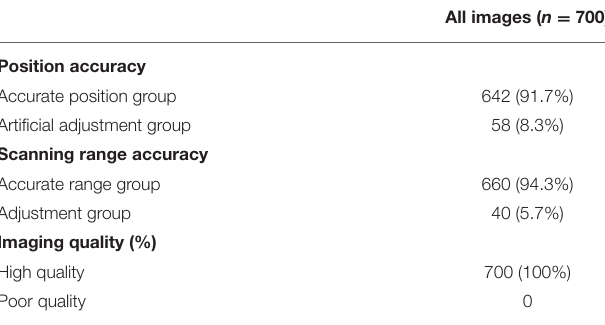
TABLE 2 | Imaging analysis of 700 scans conducted by re-locatable